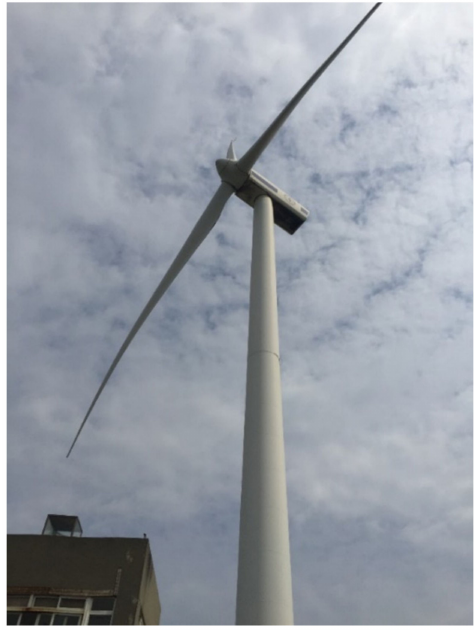
Figure 7. Selected wind turbine (N 24.157736, E 120.429382) for output